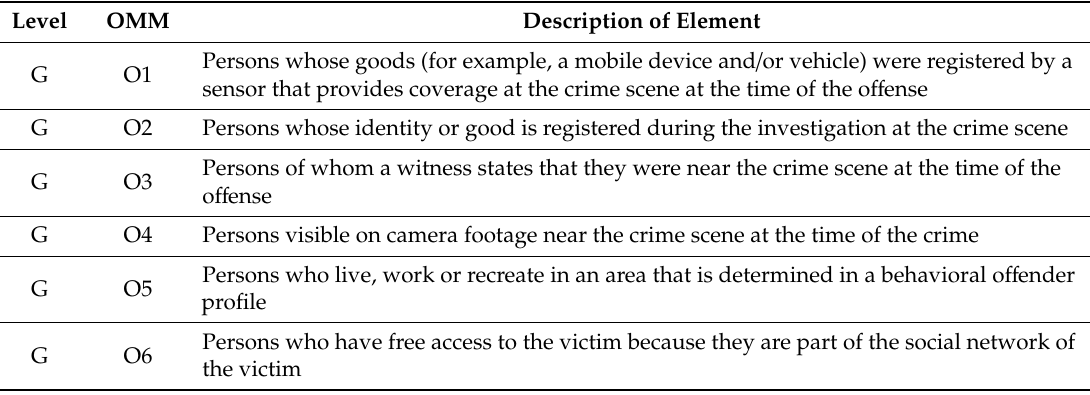
Table 1. The proposed library of elements that can be used to build a case-specific incorporation